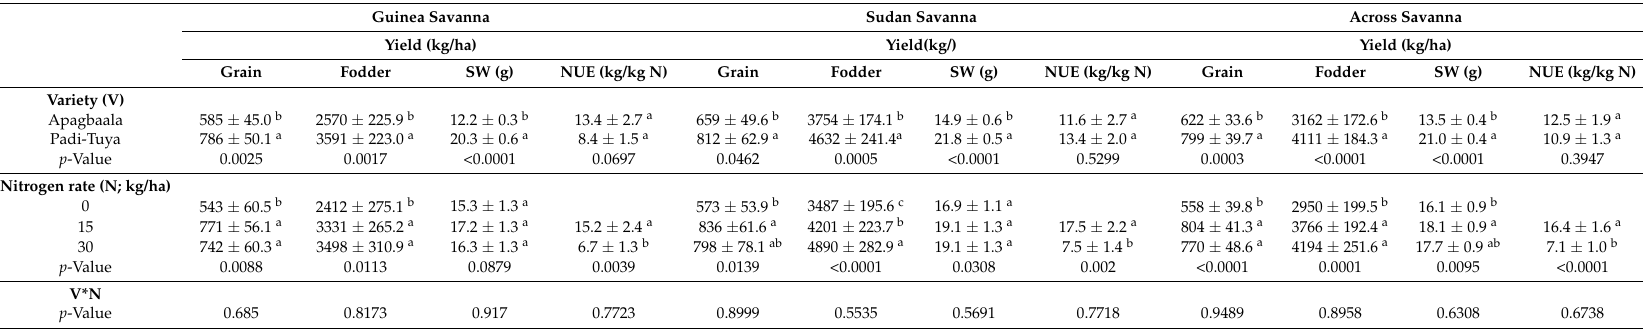
Table 1. Cowpea grain and fodder yields, 100 seed weight (SWW) and nitrogen use efficiency (NUE) as affected by variety and N fertilizer rate during 2013 and 2014 cropping seasons.